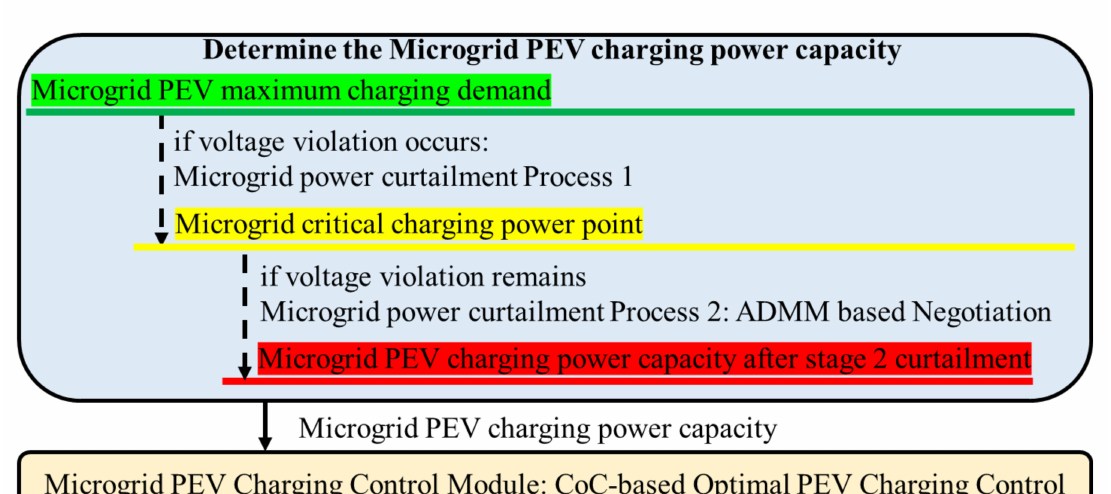
Figure 2. The determination of PEV charging power capacity in